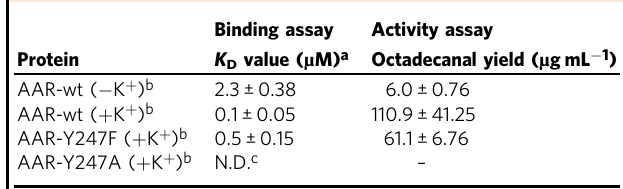
Table 3 Binding af fi nity and enzymatic activity of the wild type and mutants of AAR toward